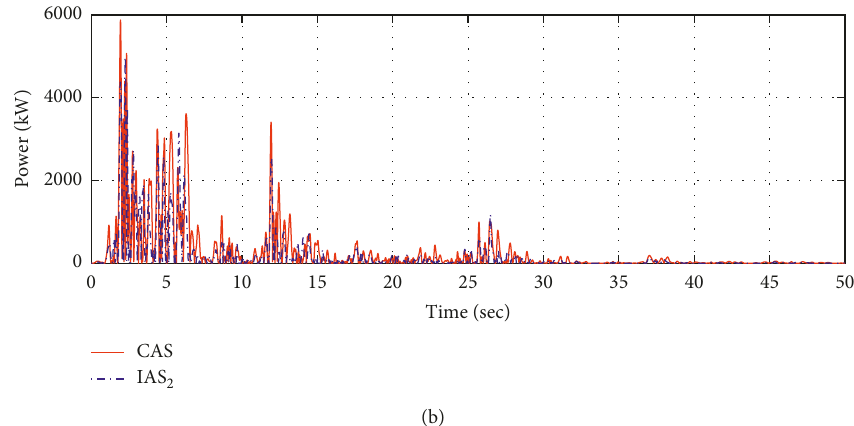
Figure 9: Comparison of control powers required to operate IAS and CAS against El Centro earthquakes. (a) Building 1. (b) Building 2. Table 6: Comparison of adaptive performances between IAS and CAS in case of one actuator being failed. Responses